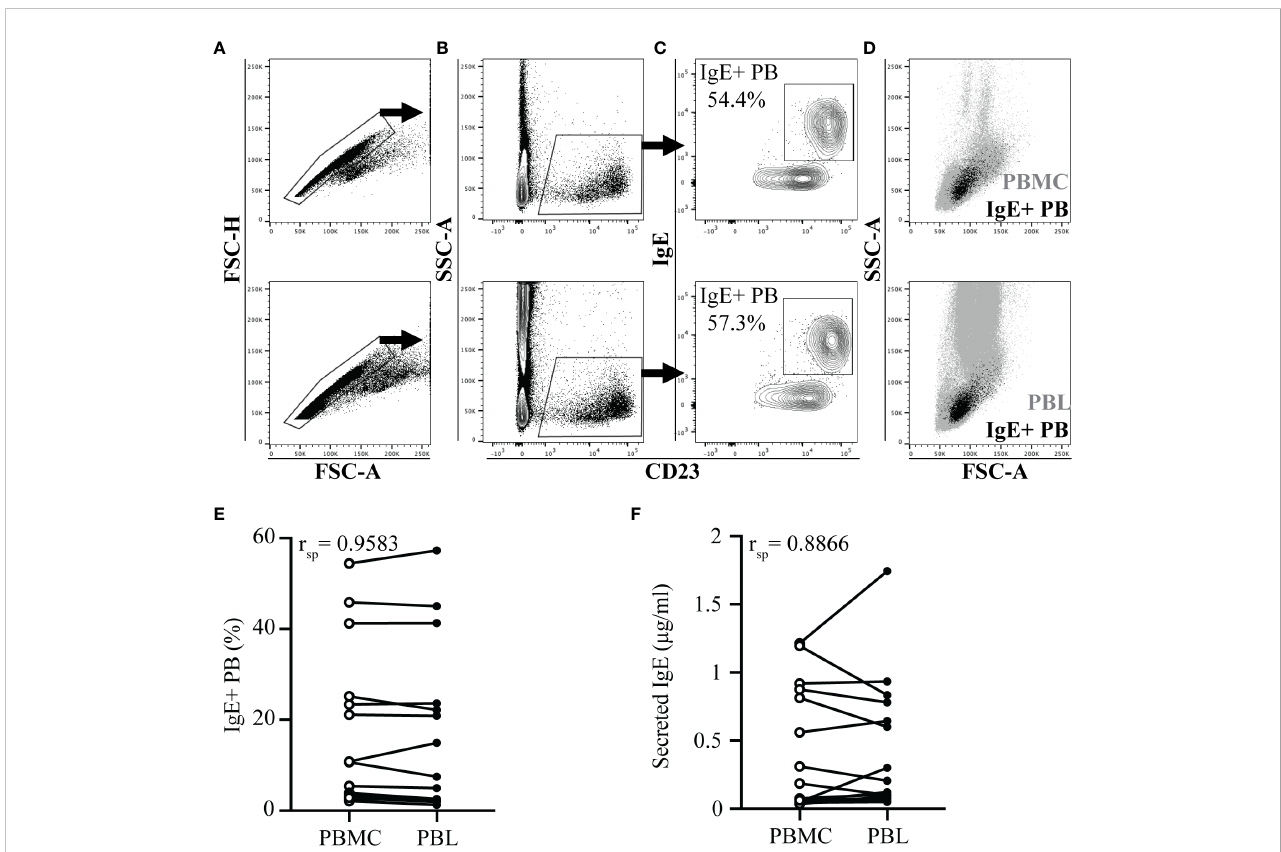
FIGURE 1 IgE + plasmablast quanti fi cation in PBL. PBMC or PBL were isolated from heparinized whole blood of 17 horses on the same day. Blood collection occurred in the summer when allergic horses had clinical allergy and elevated peripheral IgE + plasmablast frequencies. In A-D, PBMC samples are shown on the top and PBL samples are shown on the bottom. (A) Doublet exclusion. (B) CD23 expression gate on doublet excluded cells. (C) IgE and CD23 expression on CD23 + gated cells. Percentage reports IgE + plasmablasts (IgE + PB) out of total CD23 + cells. (D) Forward (FSC) and side scatter (SSC) characteristics of IgE + plasmablasts (black) in total PBMC or PBL (gray). (E) Spearman rank correlation of the IgE + plasmablast frequency in PBMC (open circles) and PBL (closed circles). (F) Spearman rank correlation of secreted IgE (µg/ml) in the supernatants of PBMC (open circles) and PBL (closed circles) after 72 hours in vitro culture. In (E-F) , samples from the same individual are connected. Flow cytometry images are representative from 1 out of 17 horses. Correlations were calculated with samples collected on July